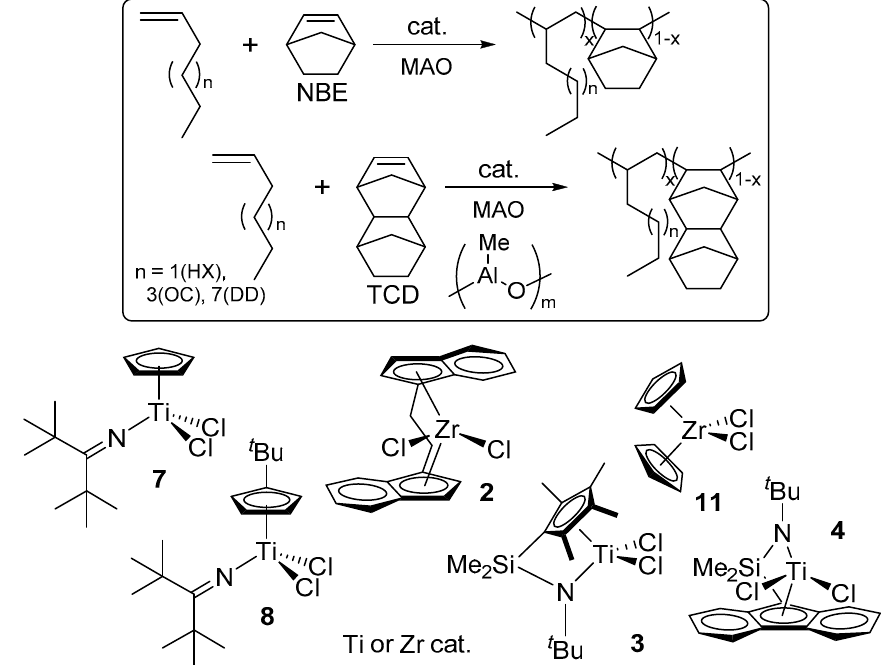
Table 3. Copolymerization of norbornene (NBE) or tetracyclododecene (TCD) with 1 ‐ hexene (HX), 1